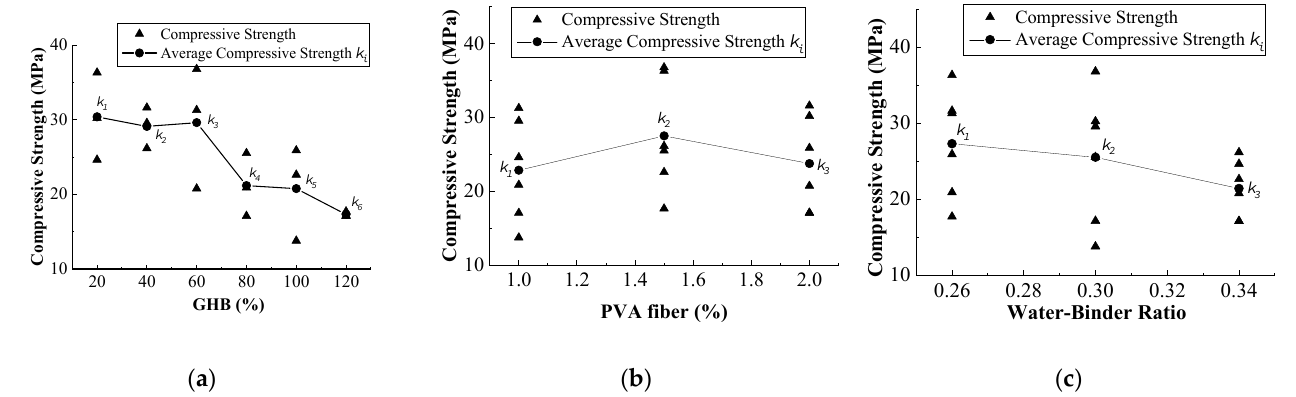
Figure 4. Relationship of GPCC compressive strength with each factor: ( a ) GHB content; ( b ) PVA Figure 5. Relationship of GPCC split tensile strength with each factor: ( a ) GHB content; ( b ) PVA fiber fiber content; ( c ) water-binder ratio. content; ( c ) water-binder